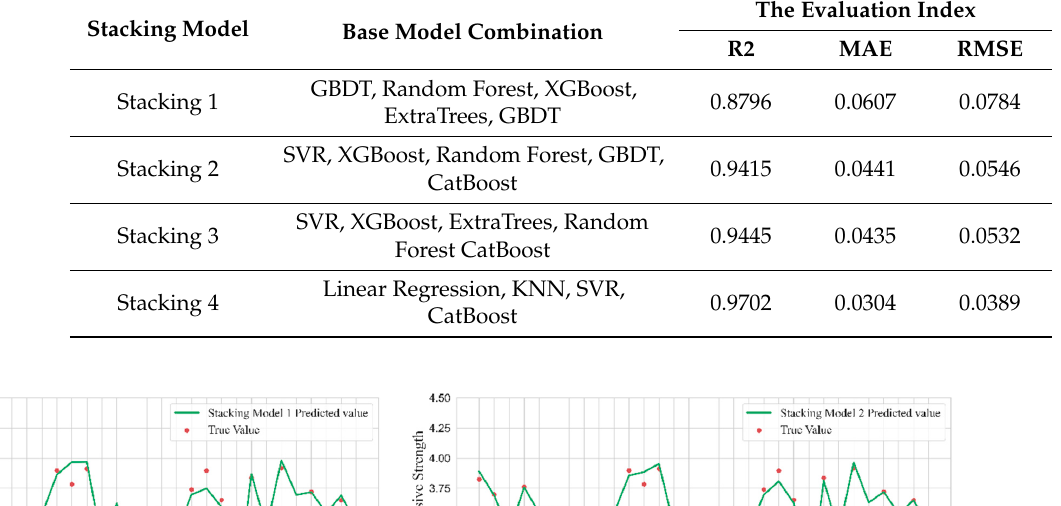
Figure 10. MIC model correlation analysis.